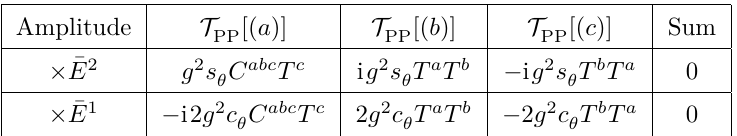
¯ q ] = T [( a )]+ T [( b )]+ → A a A b i j P P PP PP